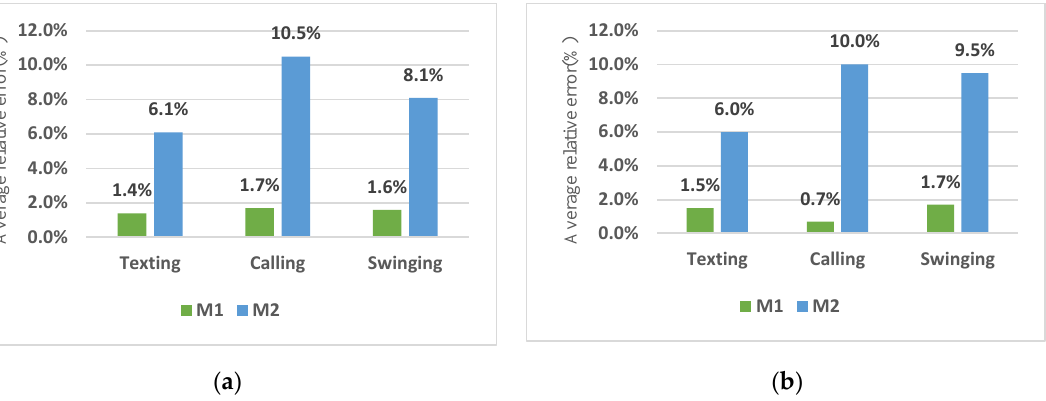
Figure 11. Comparison of the average relative error values of distance estimation; ( a ) Straight path; ( b ) Rectangular path. Table 7. Distance estimation of the straight